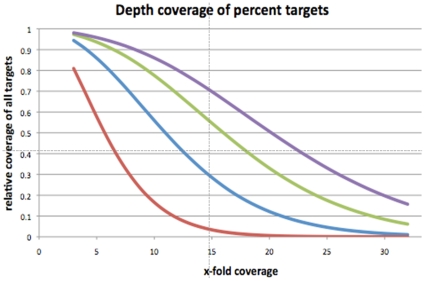
Sequence coverage of targeted exons.The graph illustrates the cumulative coverage of targeted bases after sequencing 0.5 Gbp (red), 1 Gbp (blue), 1.5 Gbp (green), and 2 Gbp (purple). 1 Gb resulted in nearly 10x coverage of 50% of all targets; 2 Gb of data increase this number to 88%. Depending on a studies goal, maximum coverage might not always be required.